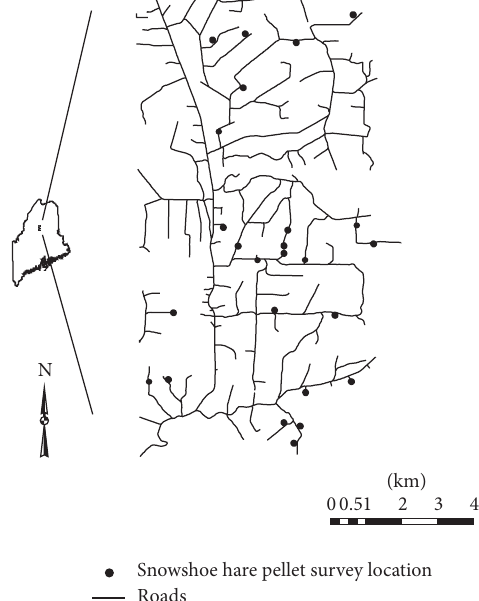
Figure 2: Location of study area and 25 snowshoe hare pellet survey locations within T4 R11 and T5 R11 WELS (460211.85N and 690910.62W), northcentral